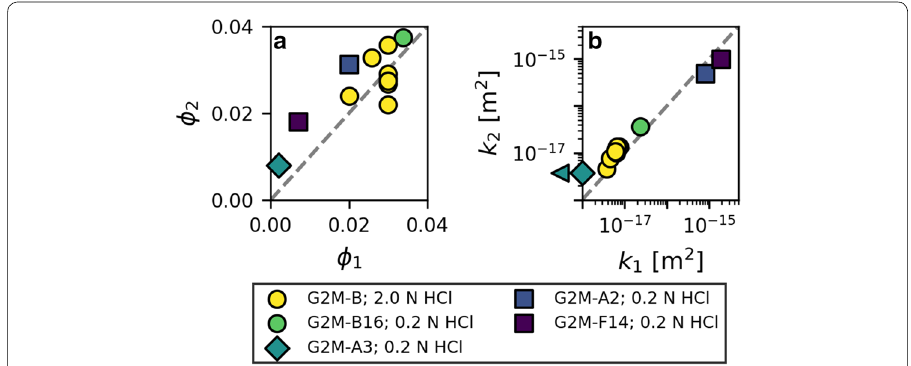
Fig. 7 Pre- and post-immersion measurements. a Porosity ( φ ). b Permeability ( k ). Subscripts 1 and 2 denote initial and post-immersion data,